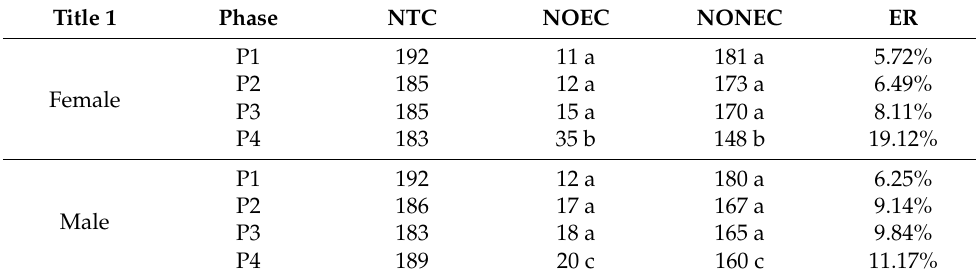
Table 6. Chi-square test of different phases’ error rate in different